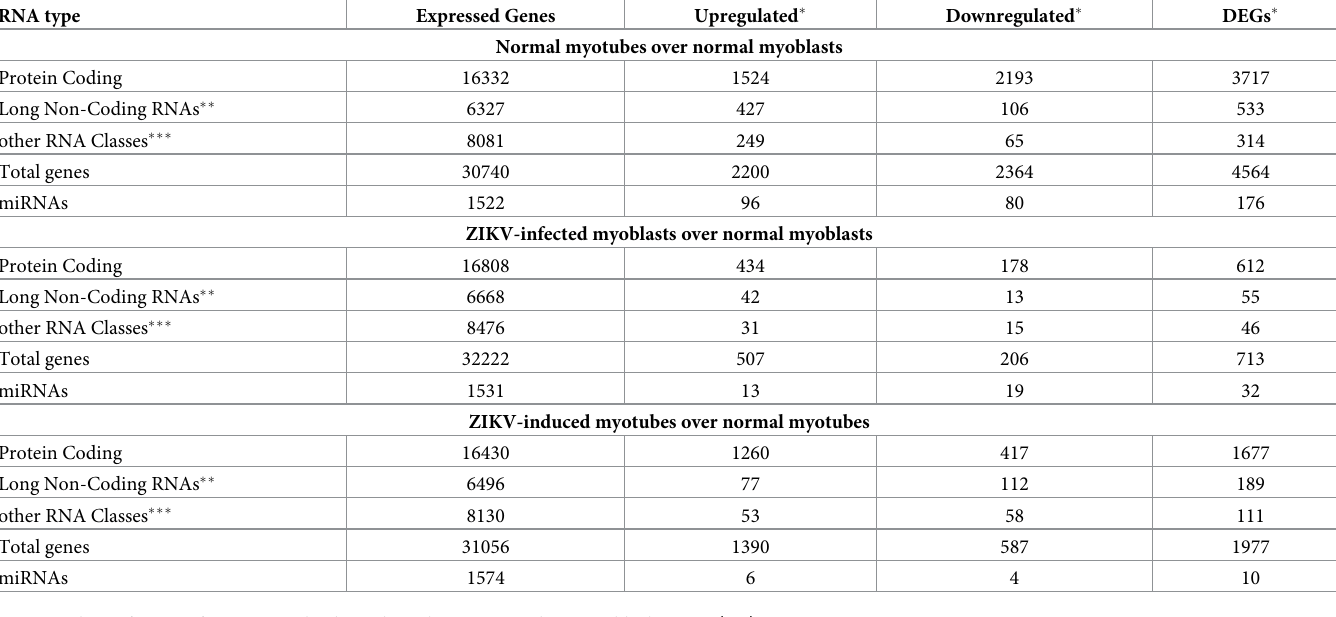
Table 1. Summary of the differentially Expressed Genes and miRNAs identified by RNAseq and small RNAseq in human myoblasts and myotubes, infected or not by ZIKV. RNA